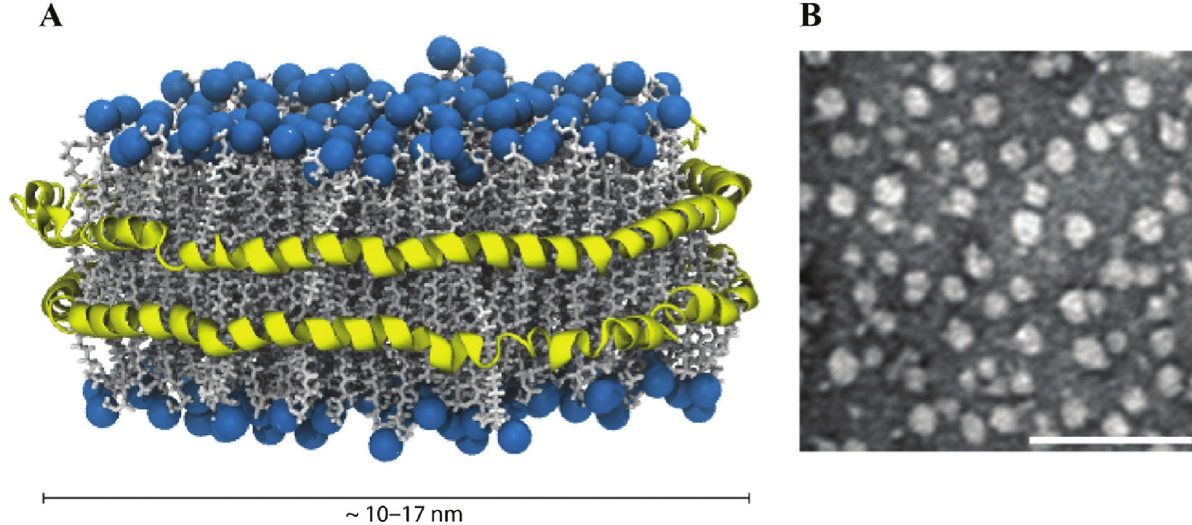
Figure 1 Phospholipid